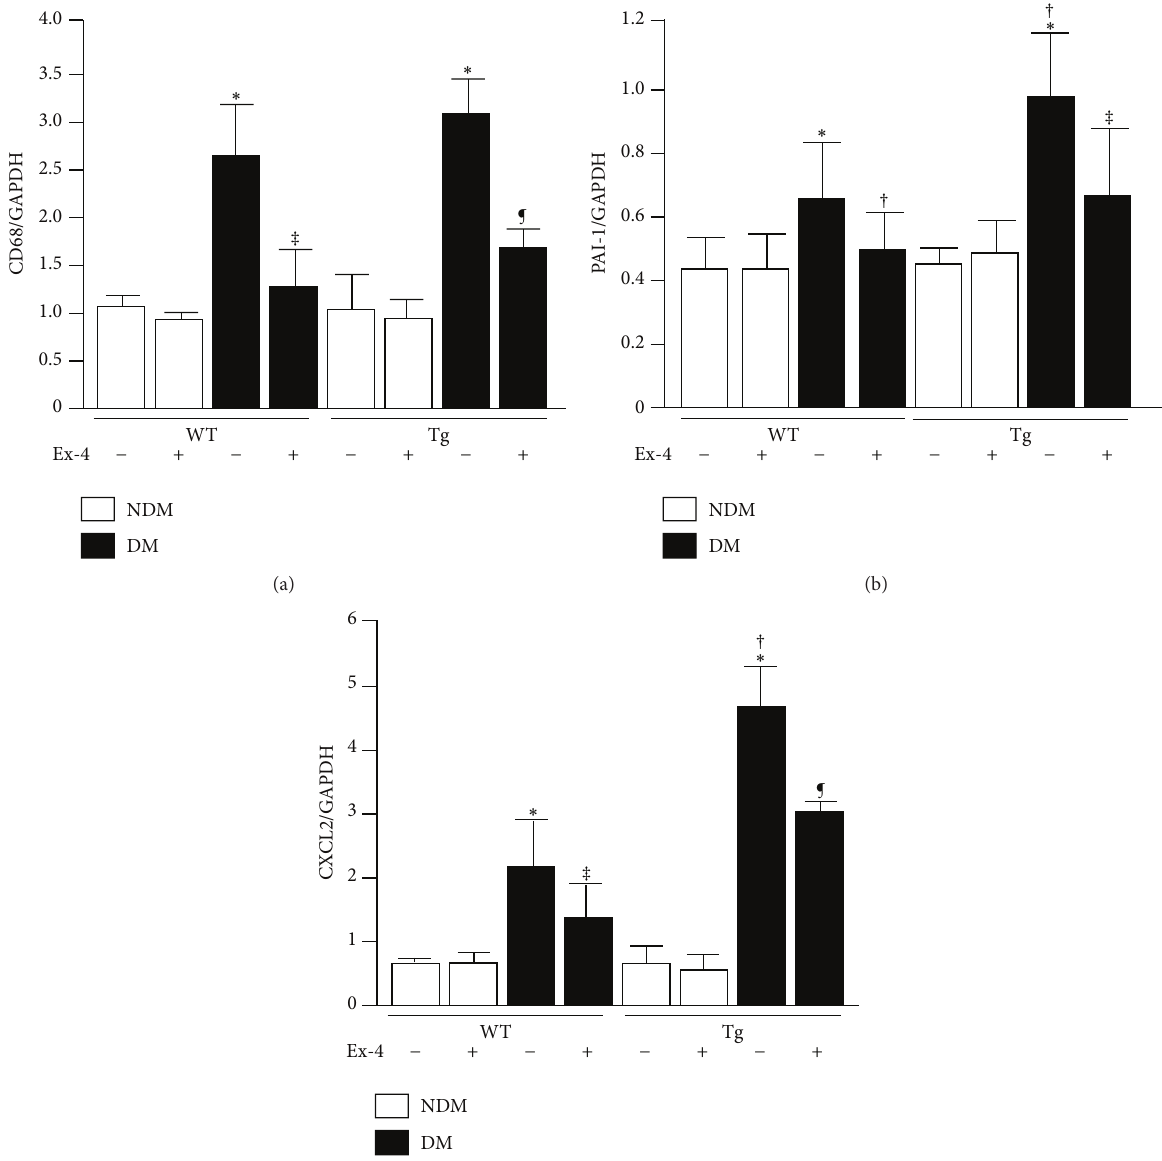
PKC 𝛽 2Tg/DM/exendin-4( − ). 𝑛 = 6 in nondiabetic WT + vehicle, nondiabetic WT + Ex-4, diabetic WT + vehicle, diabetic WT +